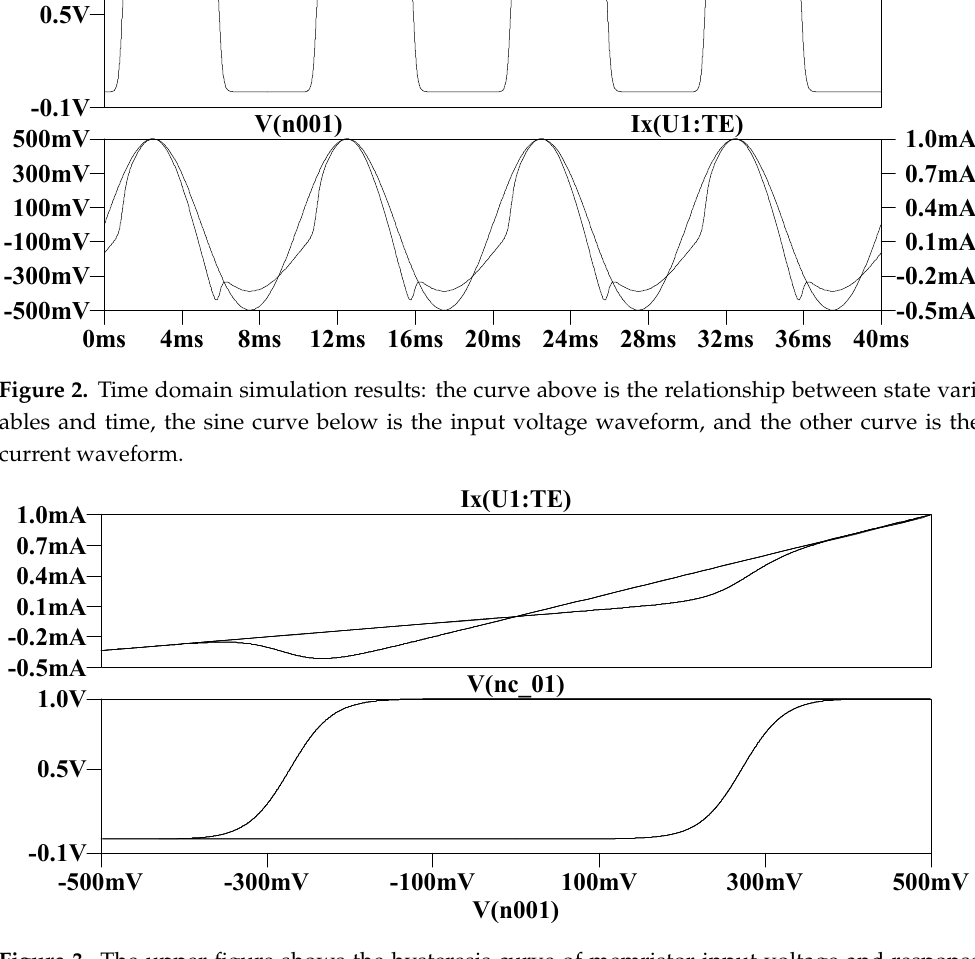
Figure 3. The upper figure shows the hysteresis curve of memristor input voltage and response current, and the lower figure shows the hysteresis curve of memristor input voltage and state var- iable.